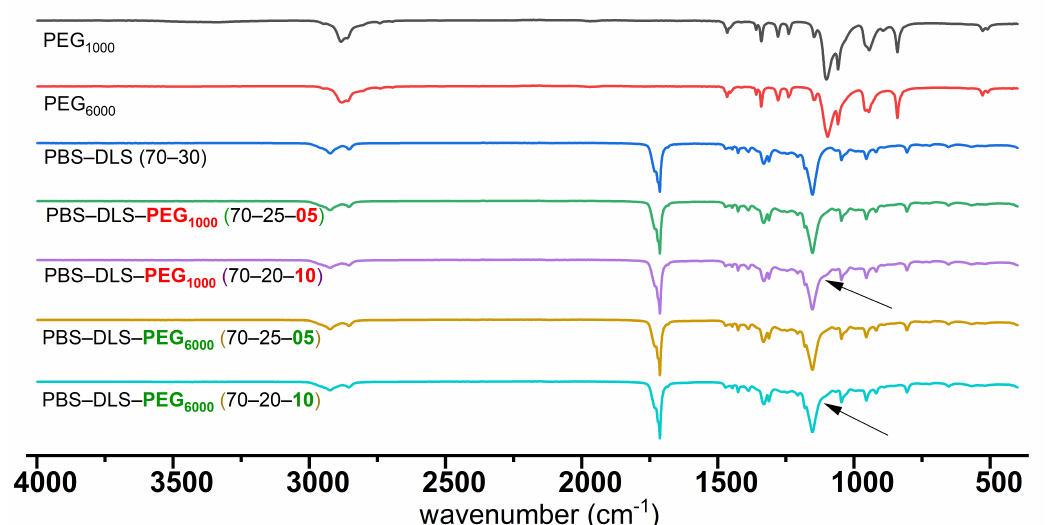
Figure 4. FTIR spectra of synthesized PBS-DLS, PBS-DLS-PEG 1000 and PBS-DLS-PEG 6000 of different segmental composi- tions (arrows indicate small band related to PEG).